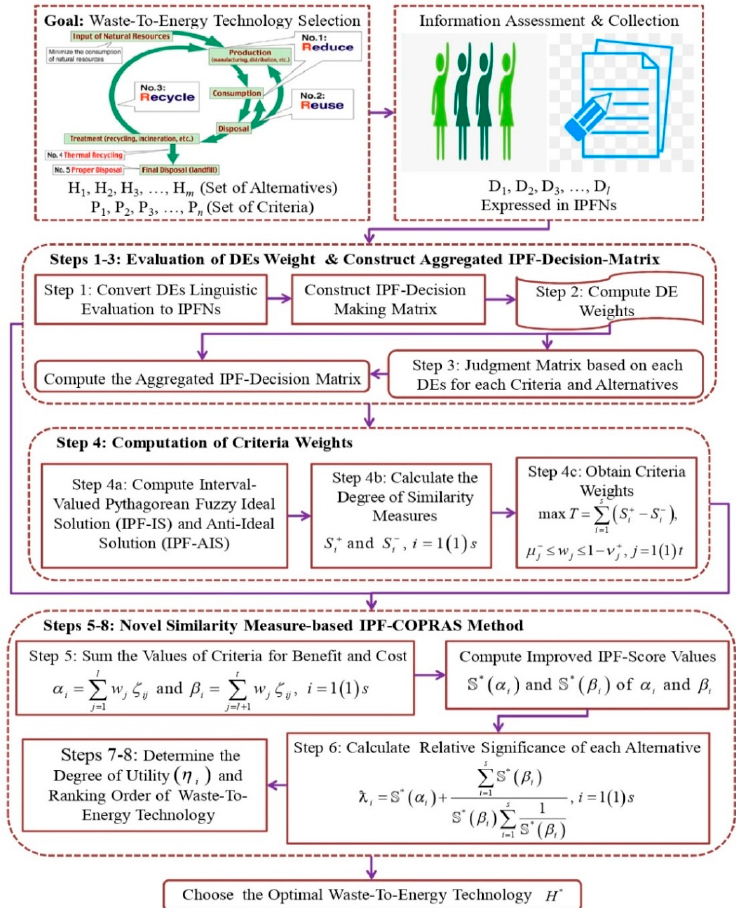
Figure 2. Performance structure of the proposed IPF-COPRAS approach.